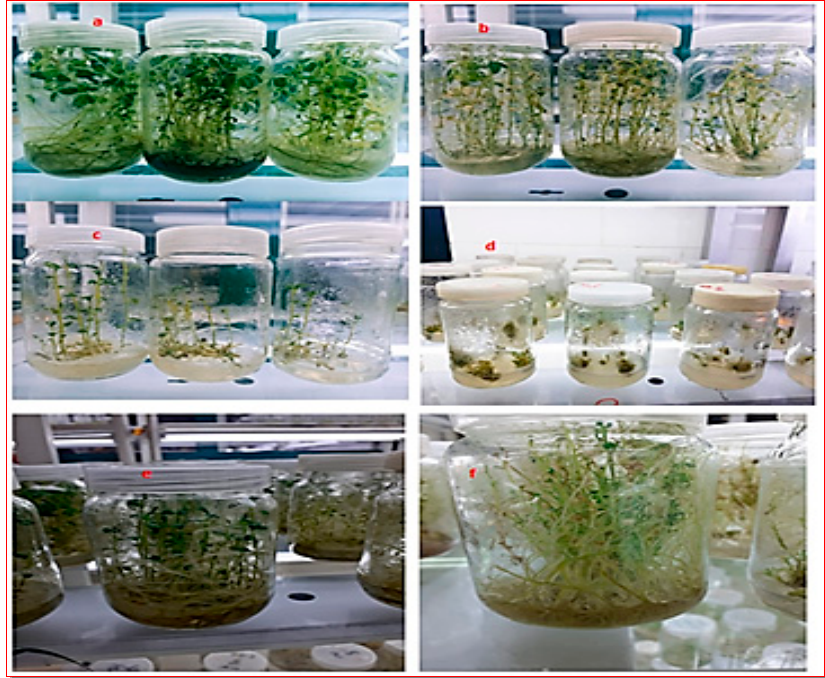
Figure 2. Plantlets regenerated from mature sprouts on culture medium containing different Chitosan (CS-NPs) concentrations. Excellent shoot regeneration, shoot proliferation, shoot length, and shoot growth on MS medium supplemented with 250 mg L of (CS-NPs) ( a ). Very good shoot regeneration, shoot proliferation, shoot length, and shoot growth on MS medium supplemented with 200 mg L of (CS-NPs) ( b ). Slow and weak shoot regeneration, shoot proliferation, shoot length, and shoot growth on MS medium supplemented with 100 mg L of (CS-NPs) ( c ). Poor shoot regeneration, shoot proliferation, shoot length, and shoot growth on MS medium supplemented with 300 mg L of (CS-NPs) ( d ). Good shoot regeneration, shoot proliferation, shoot length, and shoot growth on MS medium without treatment (Healthy control) ( e ). Weak shoot regeneration, shoot proliferation, shoot length, and shoot growth on MS medium without treatment (infected control) ( f ).